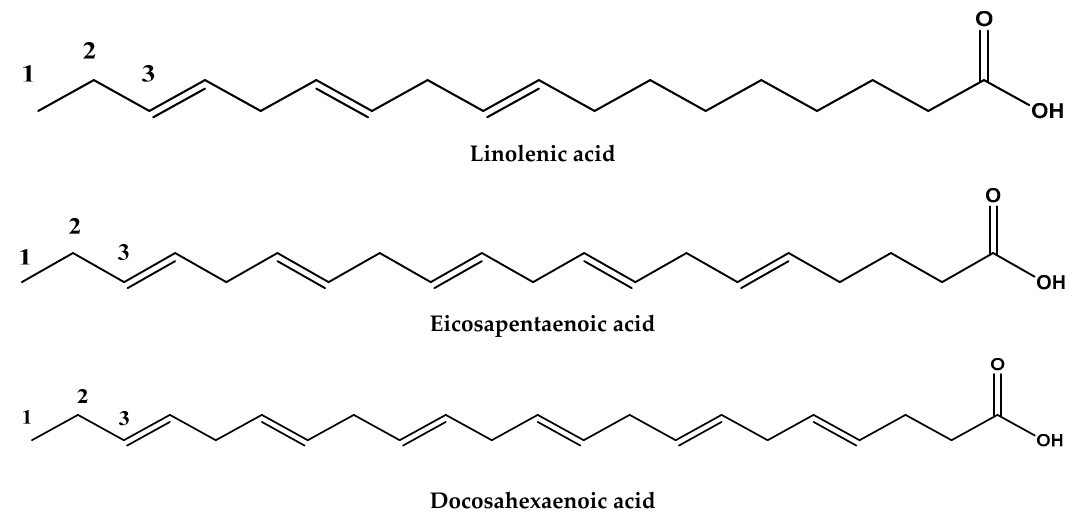
Figure 1. Chemical structures of some omega-3 fatty acids.